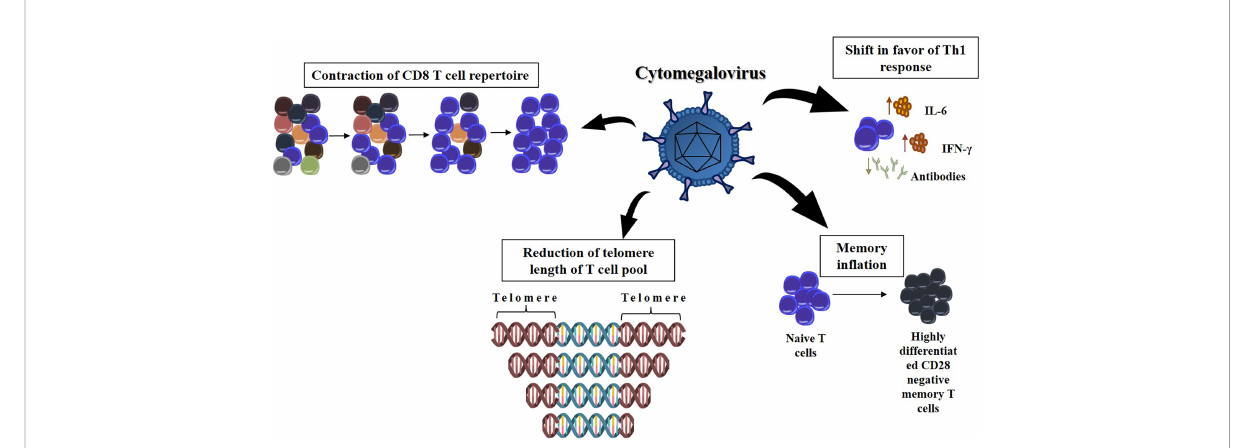
FIGURE 2 The effect of chronic infection by cytomegalovirus at the remodeling of the immune response with age. The CMV infection can dramatically decrease the T cell repertoire, narrowing the range of new pathogenic bioagents that can be recognized by the immune response. Furthermore, the presence of CMV DNA in peripheral blood monocytes was longitudinally associated with higher serum levels of IL-6, suggesting shift in favor of the Th1 immune response. Each cycle of viral reactivation generates a subset of CMV-speci fi c CD8+ T cells. It causes these terminally differentiated lymphocytes to be overrepresented in immune system (memory in fl ation). It is also possible that T cells chronically infected with CMV have shortened telomeres, which limits the lifetime these cells are available for an immune